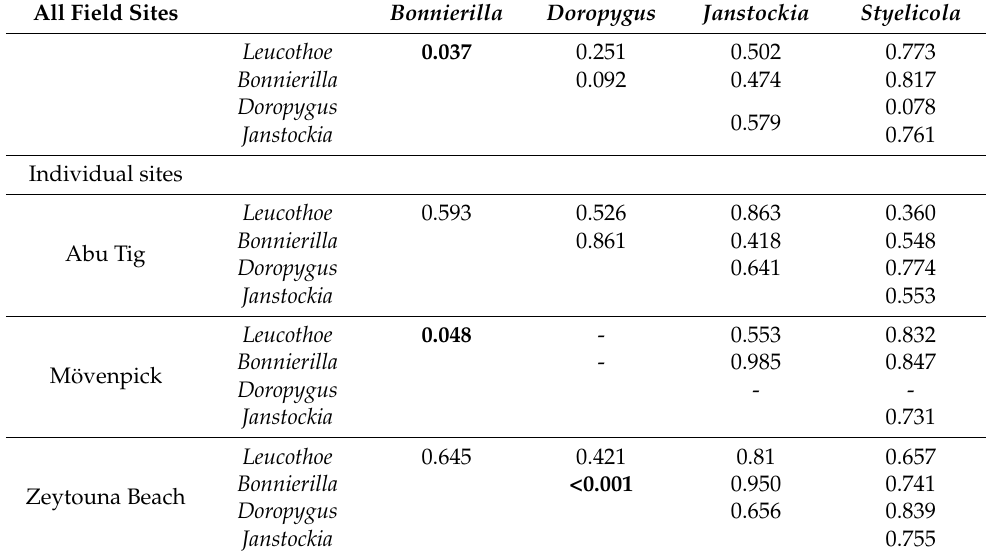
Table 2. Correlations between symbiont abundances as proxies for pairwise interactions within ascidian hosts. Analyses were conducted for all studied reefs together and individually. Numbers are p -values from two-tailed Pearson correlations. No Doropygus humilis were found at Mövenpick reef. Numbers in bold indicate significant correlations. Only positive correlations were